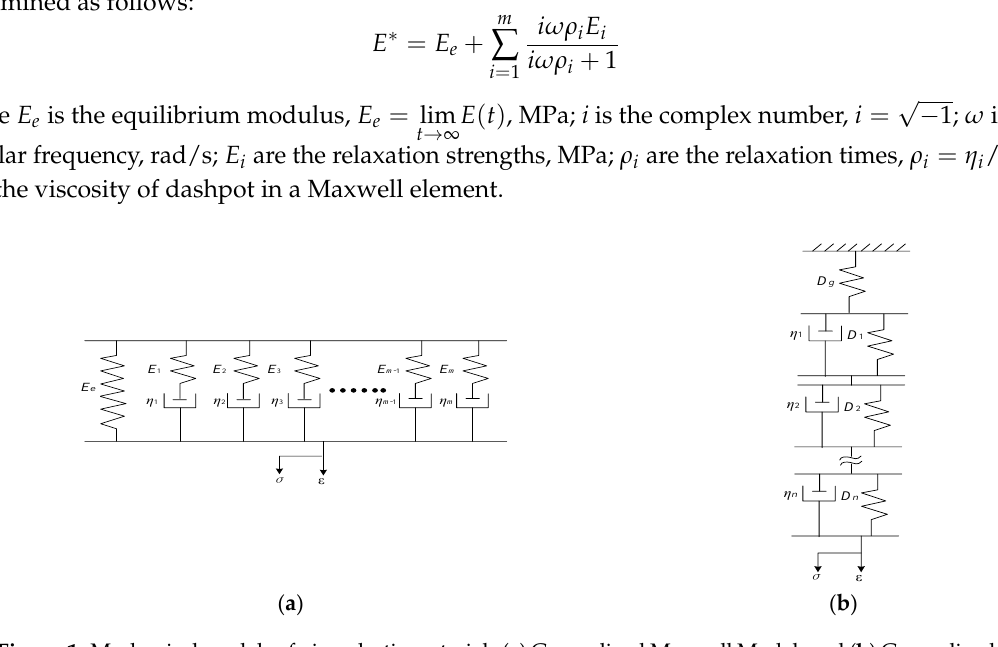
Figure 1. Mechanical models of viscoelastic materials ( a ) Generalized Maxwell Model, and ( b ) Generalized Kelvin Model.